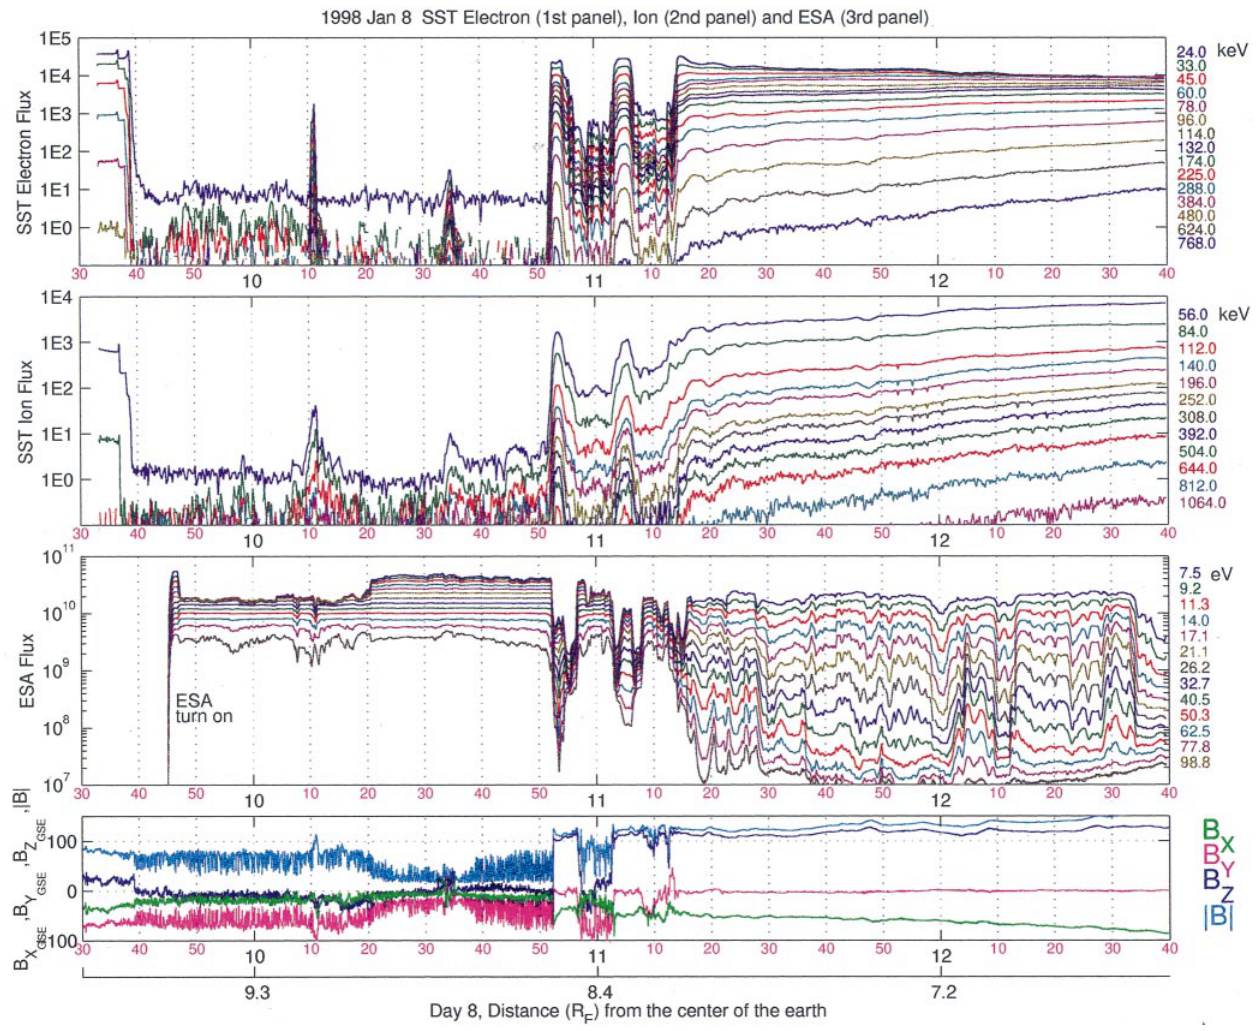
Fig. 2. A summary plot (15 s averages) of electrons with energies (cid:25) 20–300 keV ( top panel ), ions with energies (cid:25) 20–400 keV ( second panel ), electrons with energies (cid:25) 7 eV–100 eV ( third panel ), and